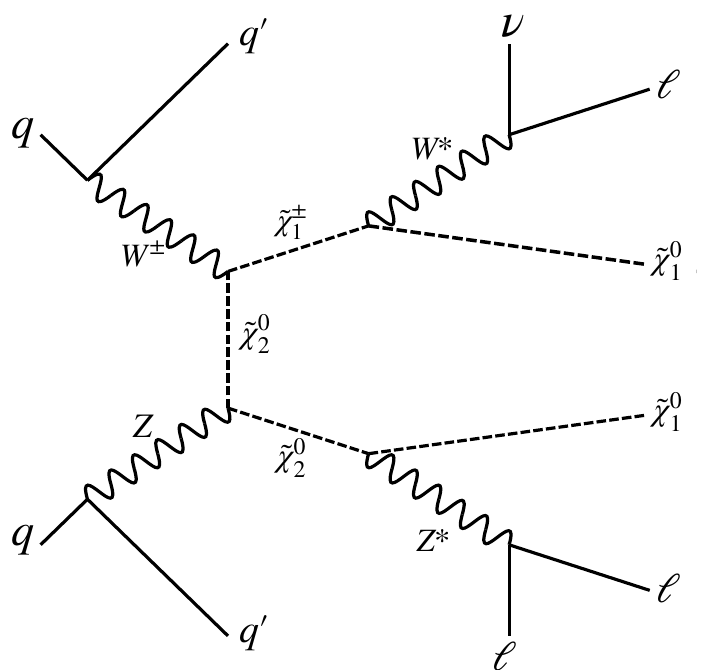
Figure 1 . Representative Feynman diagram of chargino-neutralino pair production through the t-channel WZ fusion VBF process, followed by their decays to leptons and the LSP via virtual SM